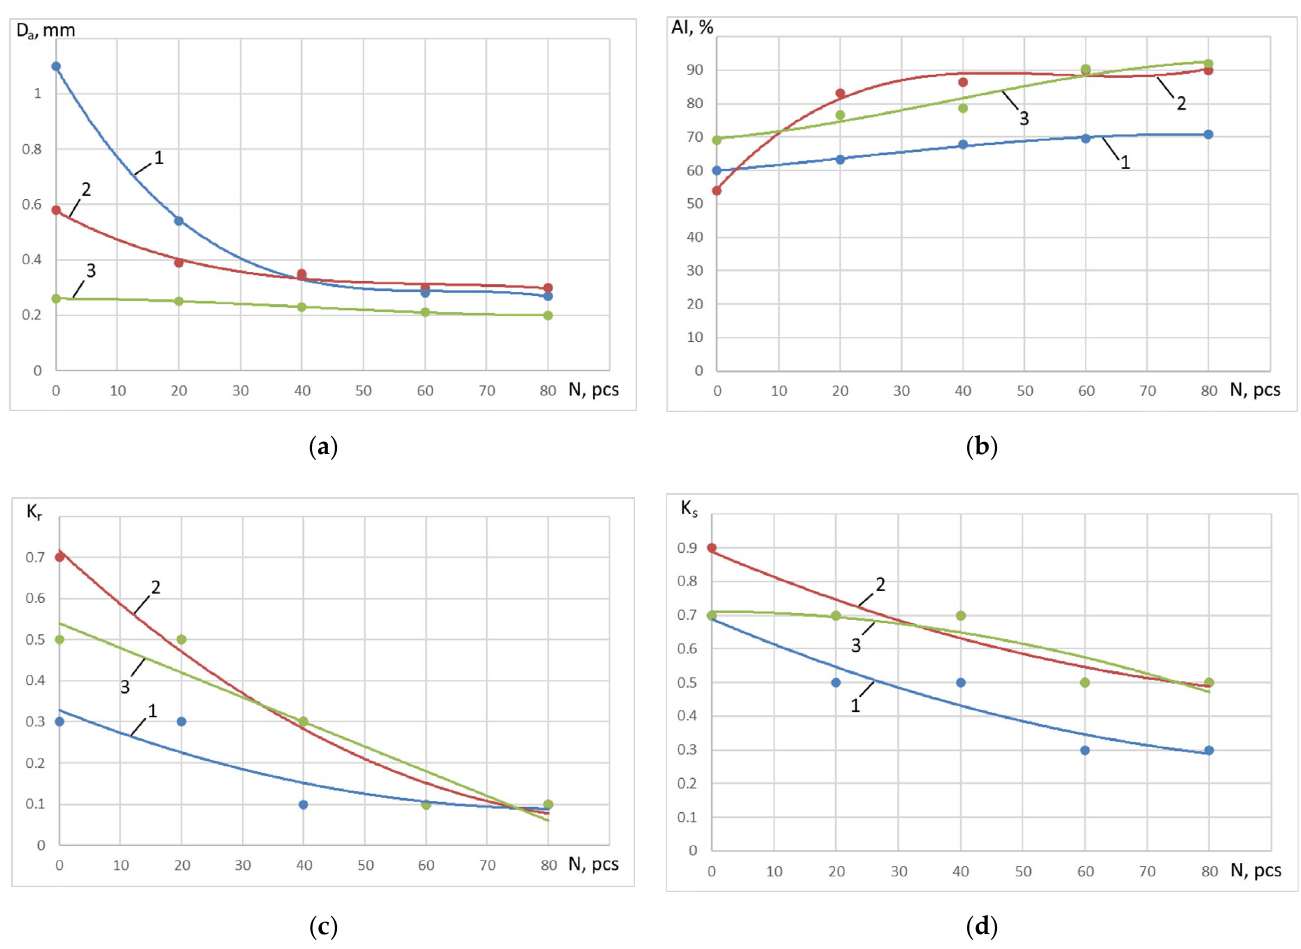
Figure 6. Changes in the average diameter ( a ), abrasiveness index ( b ), roundness coefficient ( c ) and sphericity coefficient ( d ) of sand particles contained in the hydroabrasive mixture during passing through the pump stages of the electric centrifugal pump: 1 —quartz sand of artificial origin, D i = 1.1 mm; 2 —river sand, D i = 0.58 mm; 3 —river sand, D = 0.26 mm.